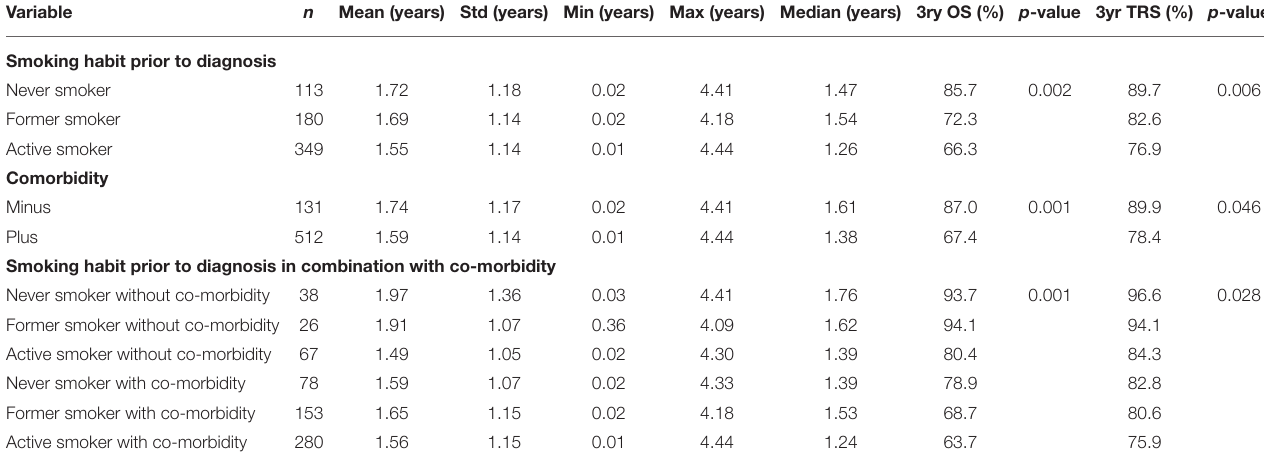
TABLE 3 | Kaplan-Meyer analysis showing overall (OS) and tumor related (TRS) survival dependent on smoking habit, patients’ comorbidity and the correlation of both.